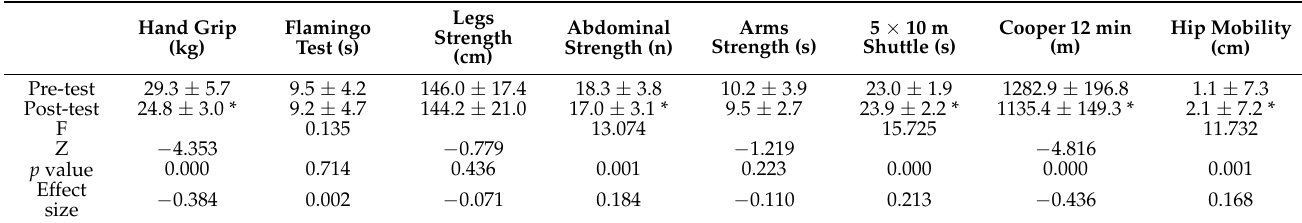
Table 2. Motor fitness test battery results collected before (pre-test) and after (post-test) the twelve weeks of training restrictions.